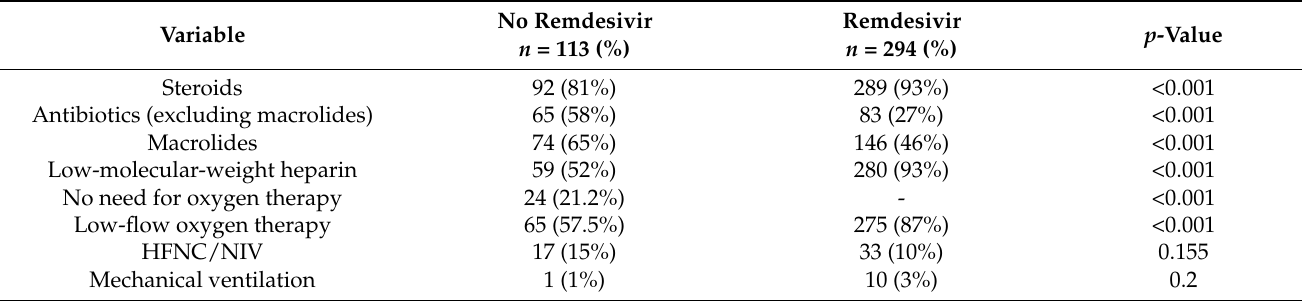
Table 2. In-hospital treatments for COVID-19 patients treated with remdesivir or